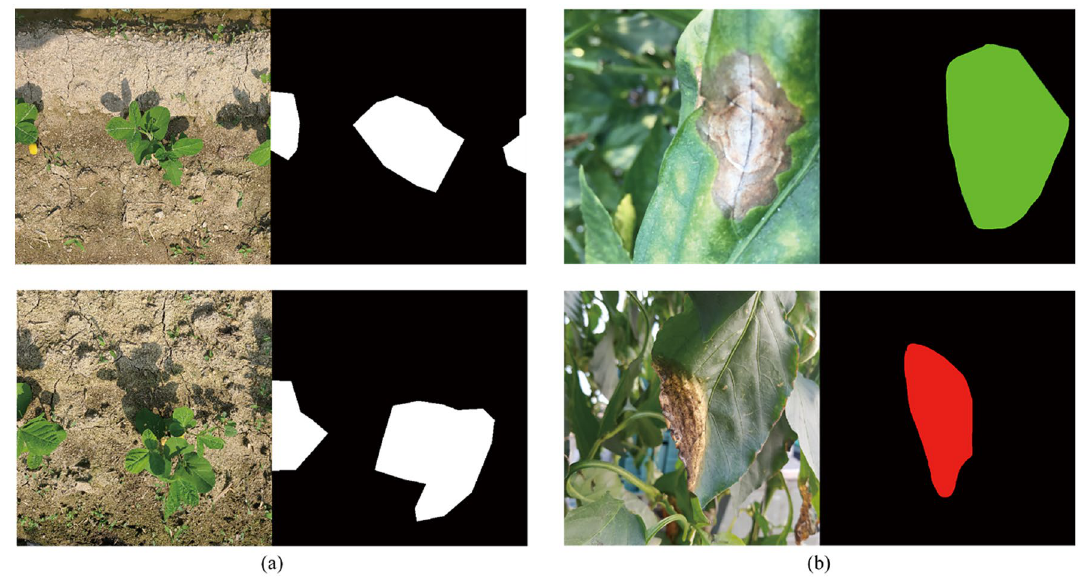
Figure 3. Input data sample and corresponding manually generated rough labels (MGRLs), ( a ) Bean-Field Dataset, ( b ) Paprika-Disease